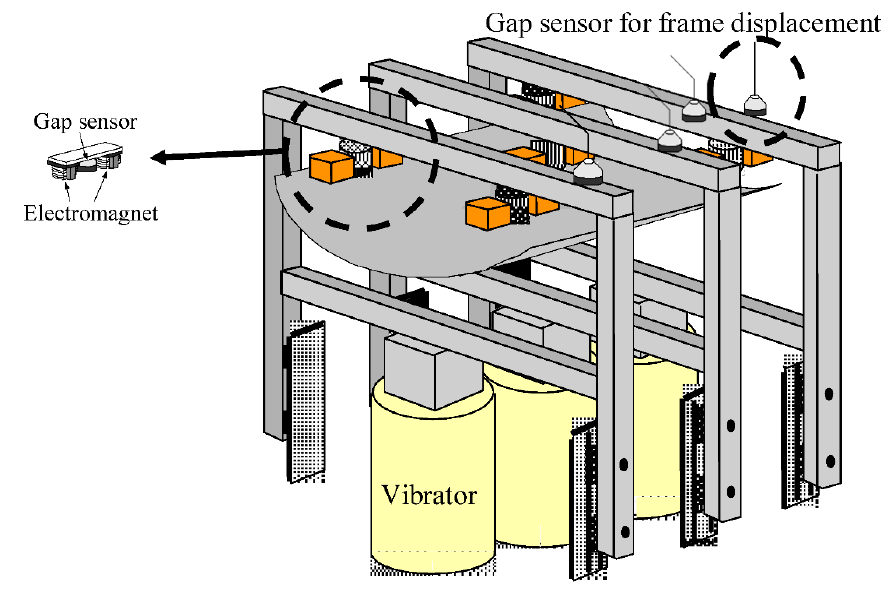
Figure 2. Schematic illustration of the experimental apparatus.